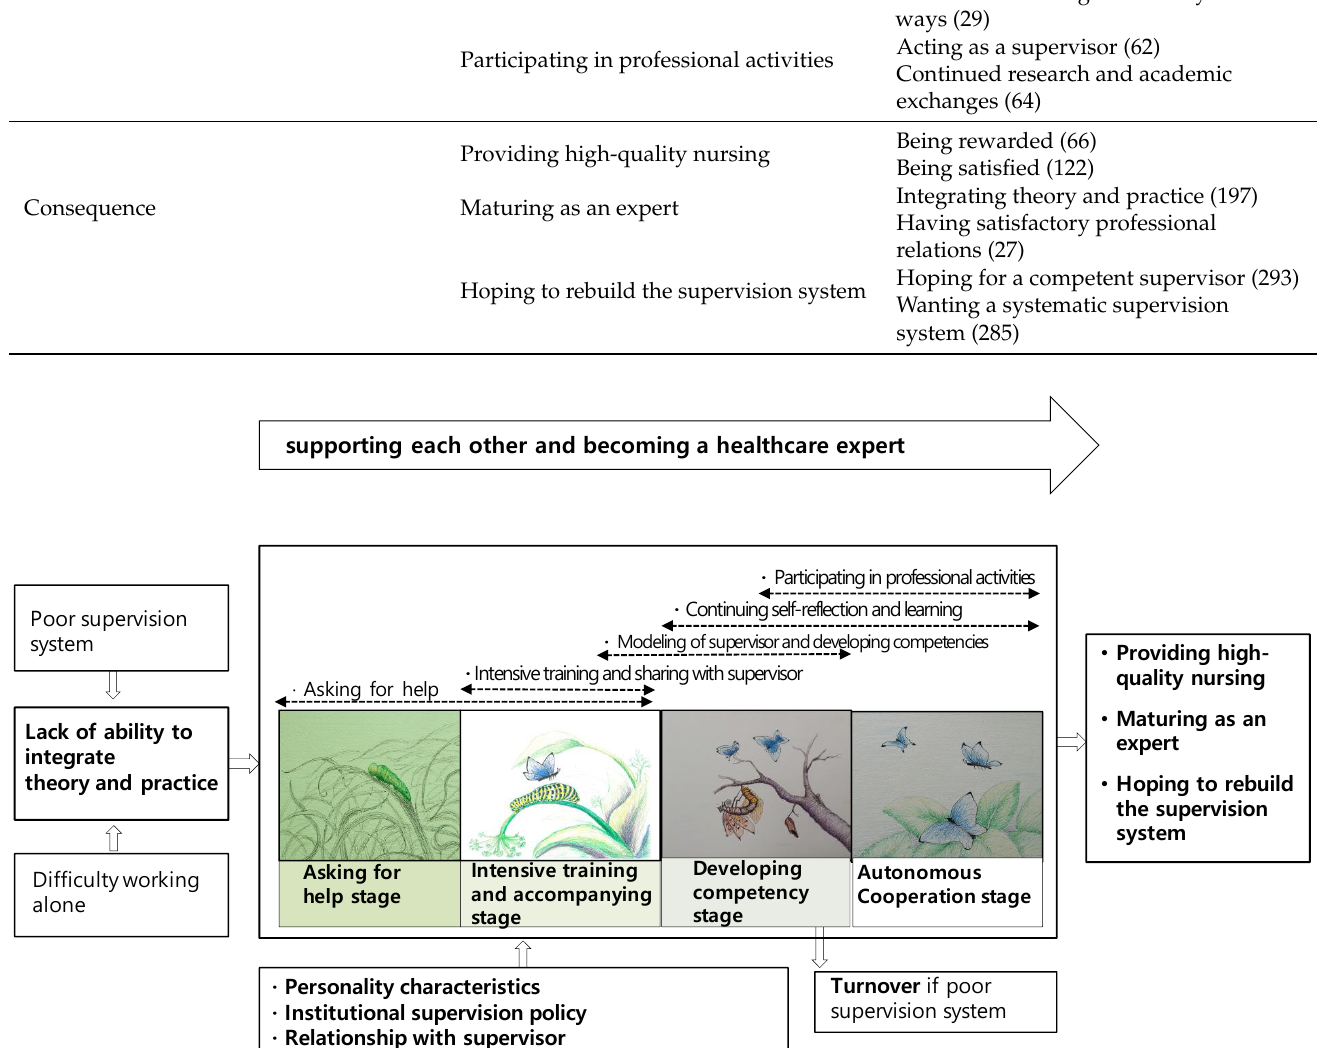
Figure 1. Model of developmental process in the clinical supervision of mental health nurse practitioners. Figure 1. A model of experiences of psychiatric mental health nurse practitioners in clinical supervision. The frequency of the analyzed subcategories was added to Table 2 by classifying the verbatim (A4 Korean page 287, Excel raw data analyzed by semantic